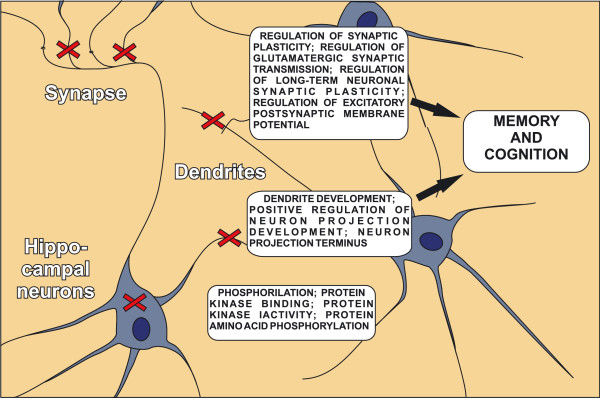
A schematic representation of MDMA’s sites of action in the Hippocampus. This figure summarizes the effects of a single-dose (15 mg/kg, intraperitoneal) of 3,4-methylenedioxymethamphetamine (MDMA) 3 weeks earlier on hippocampal neurons in Dark Agouti rats. Three distinct processes were identified marked by text boxes on the figure, phosphorylation- and dendrite development-related gene sets and gene sets involved in the proper synaptic functioning were downregulated (signed with red crosses at possible sites of action). These processes can be bound to memory and cognition gene sets (downregulated alike) through a single mediator, namely the type 1 cannabinoid receptor (CB1). Accordingly, single-dose MDMA administration 3 weeks earlier resulted in elevated CB1 mRNA levels in the hippocampus. It has to be noted that compared to the frontal cortical region (Figure 
5), where rather intracellular signaling mechanisms were influenced, in the HC gene sets related to the connectivity of neurons were damaged. See text for further details.